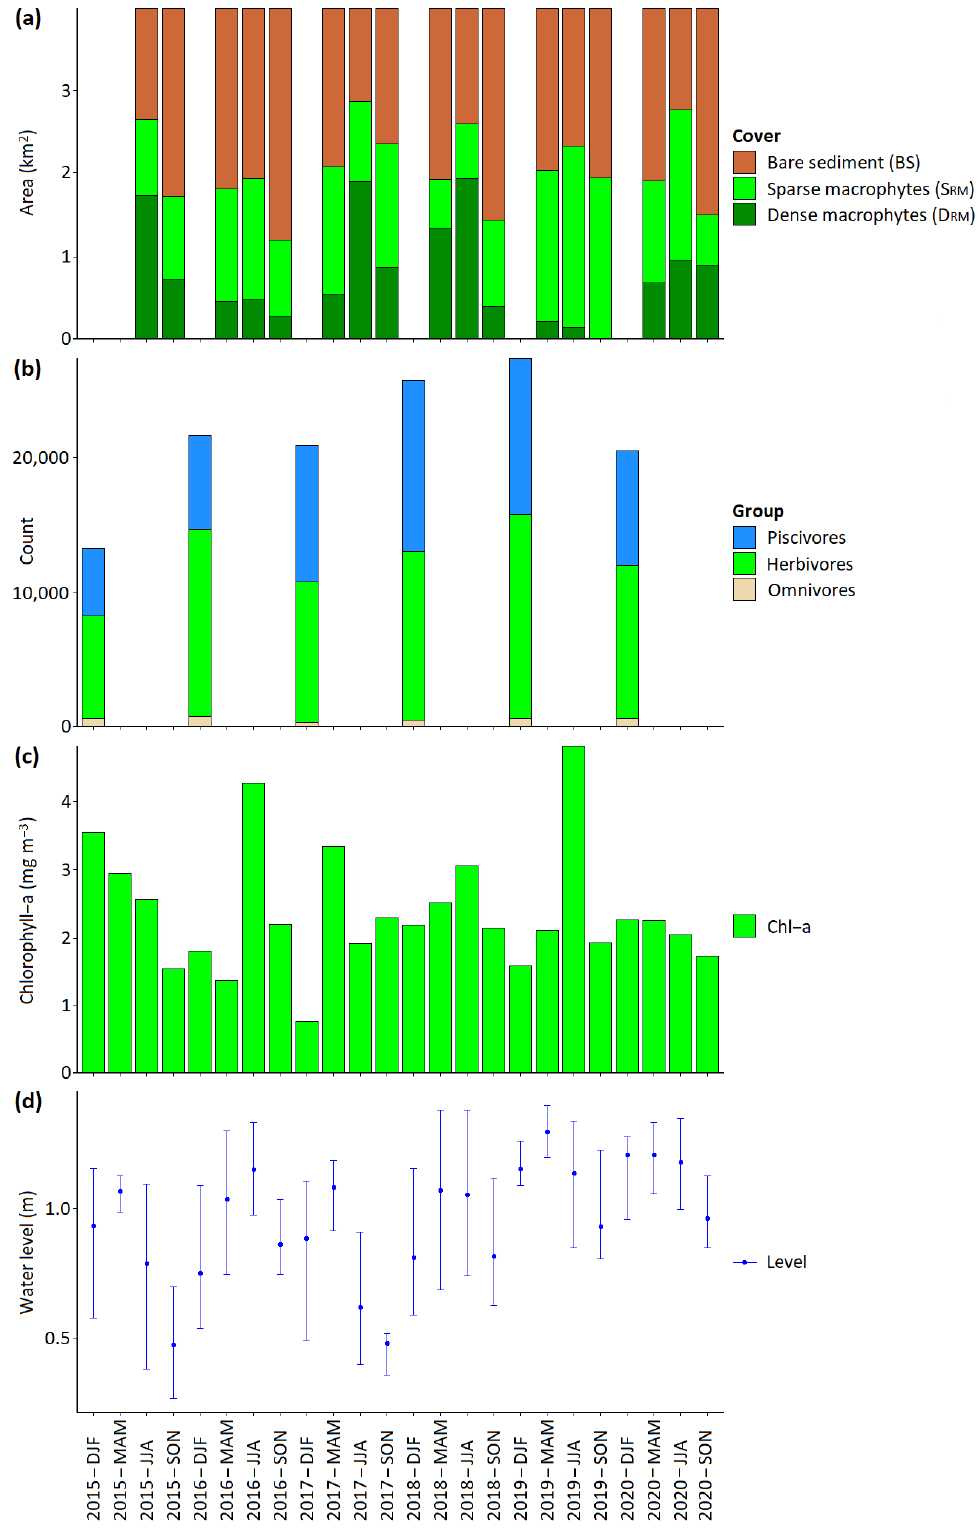
Figure 3. From top to bottom: ( a ) Time series of macrophyte cover (bare sediment = BS, sparse macrophyte = S RM , dense macrophyte = D RM ); ( b ) Bird groups (piscivores, herbivores, omnivores); ( c ) Chlorophyll – a (Chl – a); ( d ) Water level (m) in Lake Garda.